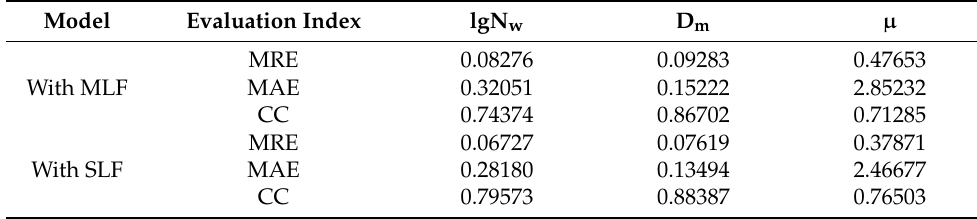
Table 8. The 30-min prediction evaluation results of convective clouds.